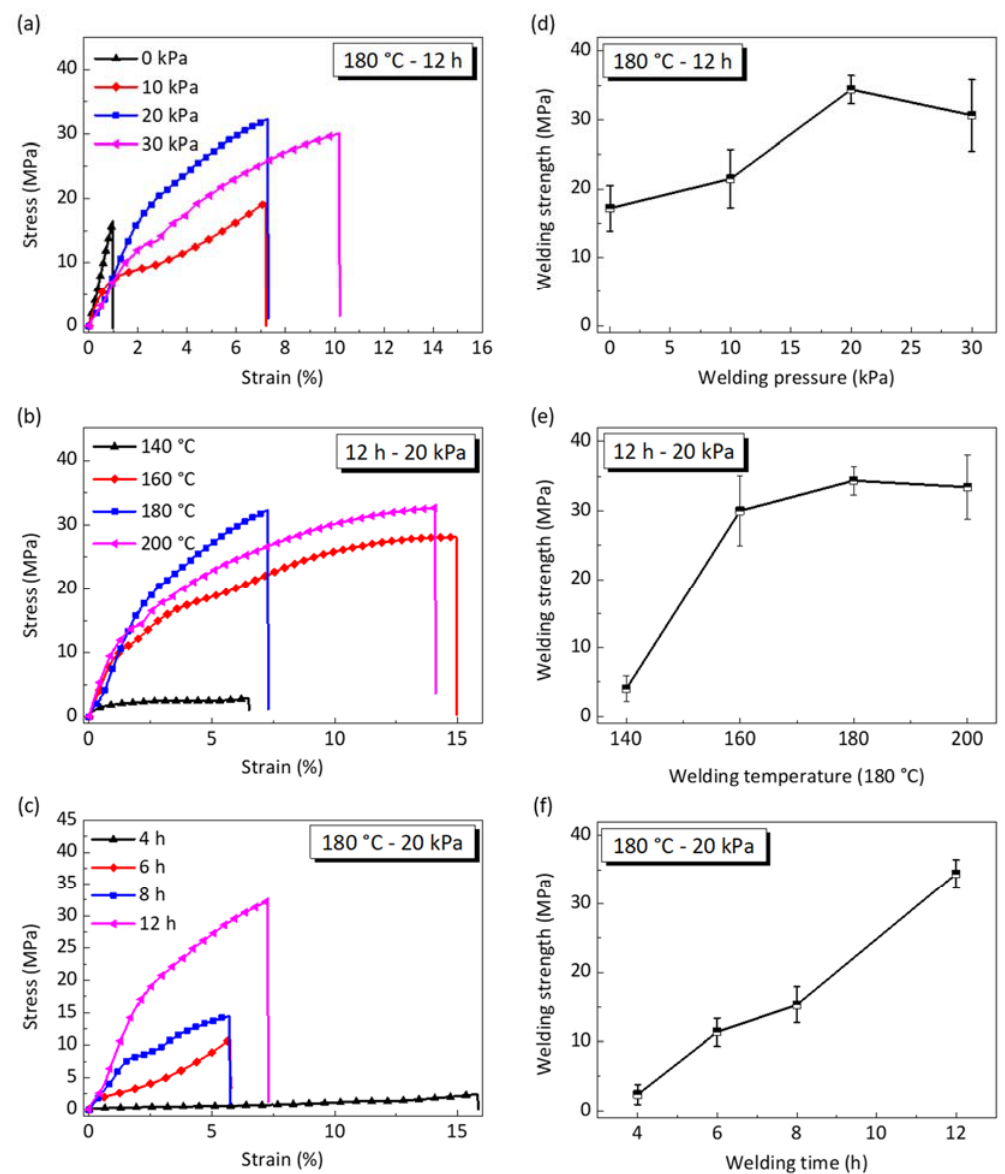
Figure 6. Effect of welding conditions on the mechanical behavior of butt ‐ welded epoxy vitrimer. All of the epoxy vitrimers are depolymerized at 180 °C for 40 min before welding. Stress – strain curves under different ( a ) welding pressure, ( b ) welding temperature, and ( c ) welding time. The welding strength varies with ( e ) welding pressure, ( e ) welding temperature, and ( f ) welding time. Each data point represents the mean and stands deviation of three measurements.